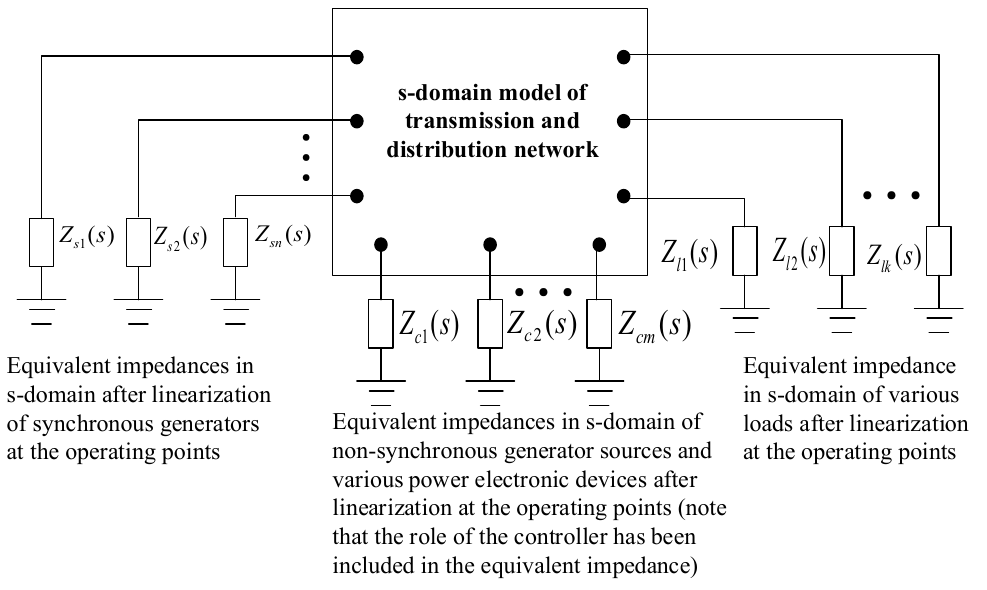
Figure 12. Pure s-domain impedance model of power systems for establishing the s-domain nodal admittance matrix.